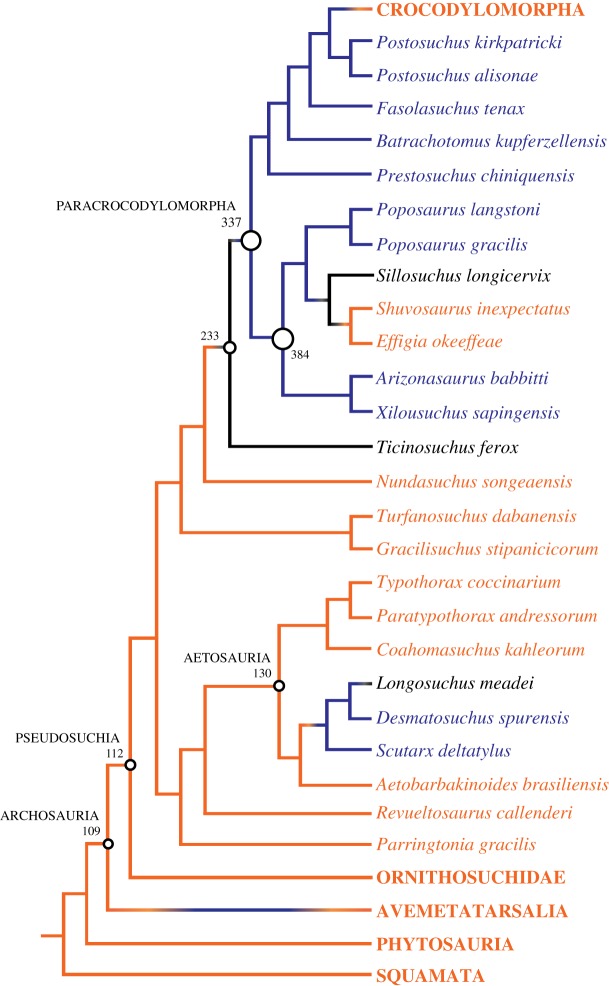
Phylogenetic tree of Pseudosuchia (from [25,29,61,64,65,67,72]) with the presence (blue), absence (orange), or ambiguity (black) of the hyposphene-hypantrum articulation mapped on and ancestral state femoral length reconstructions (from [11]) illustrated at several major clades.